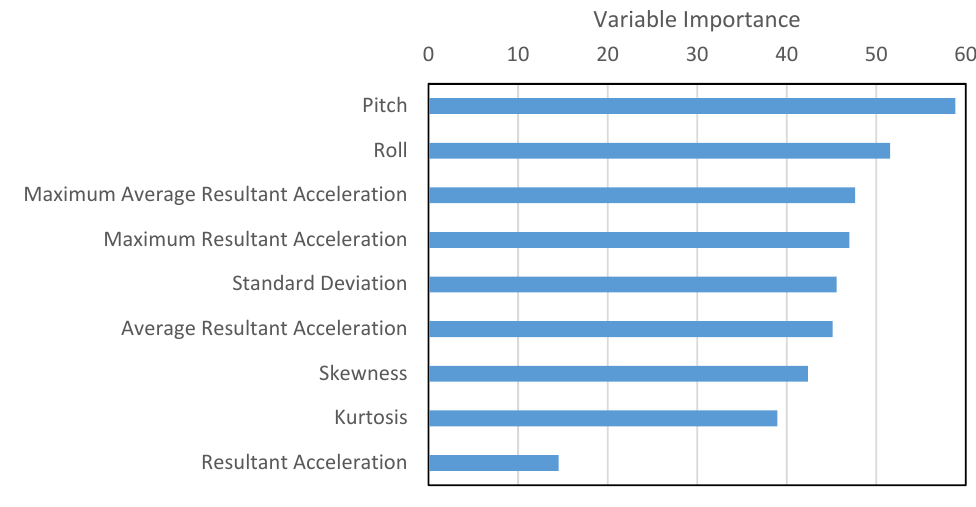
Figure 14. Variable Importance. Figure 14. Variable